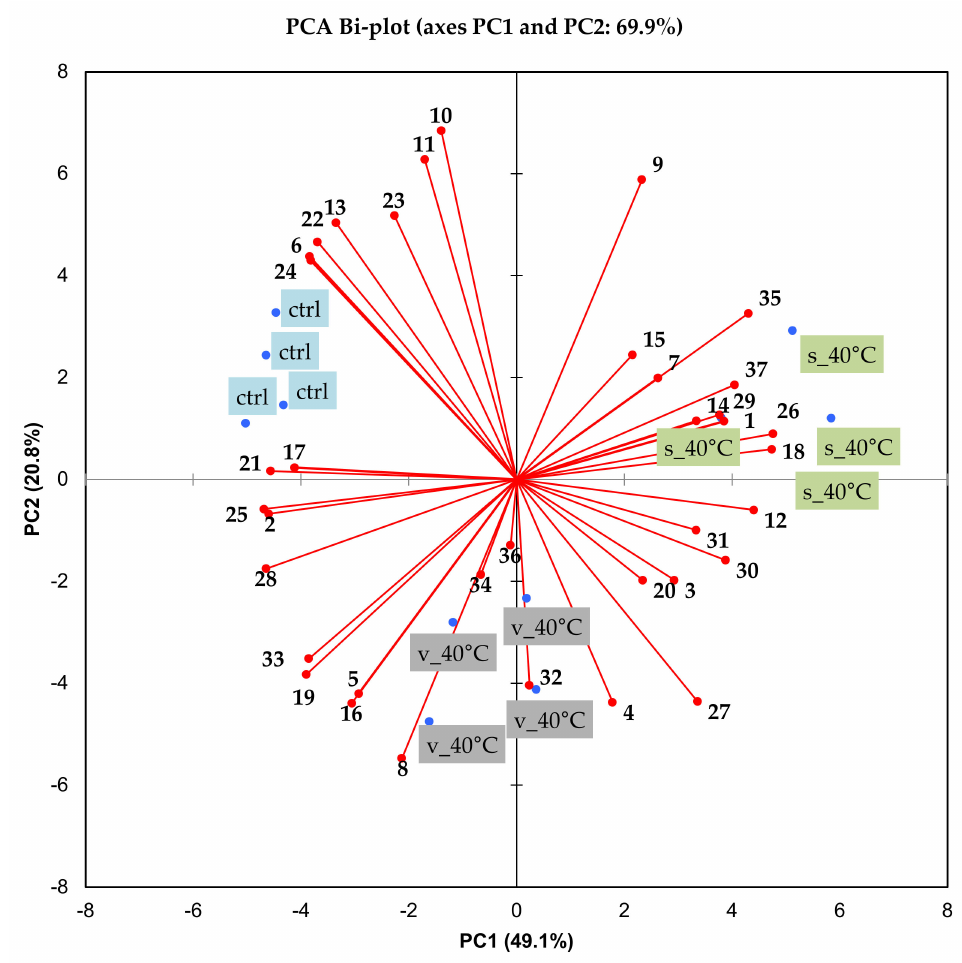
Figure 9. Principal component analysis (PCA) bi-plot showing the position of identified volatile compounds in relation to M3 reconstituted in water to beverage strength (green rooibos extract microencapsulated with inulin in 1:1 ratio (m/m), xylitol, and citric acid), before storage (control, ctrl) and stored at 40 ◦ C/65% RH for 1 month in sealed glass vials ( v ) and semi-permeable sachets ( s